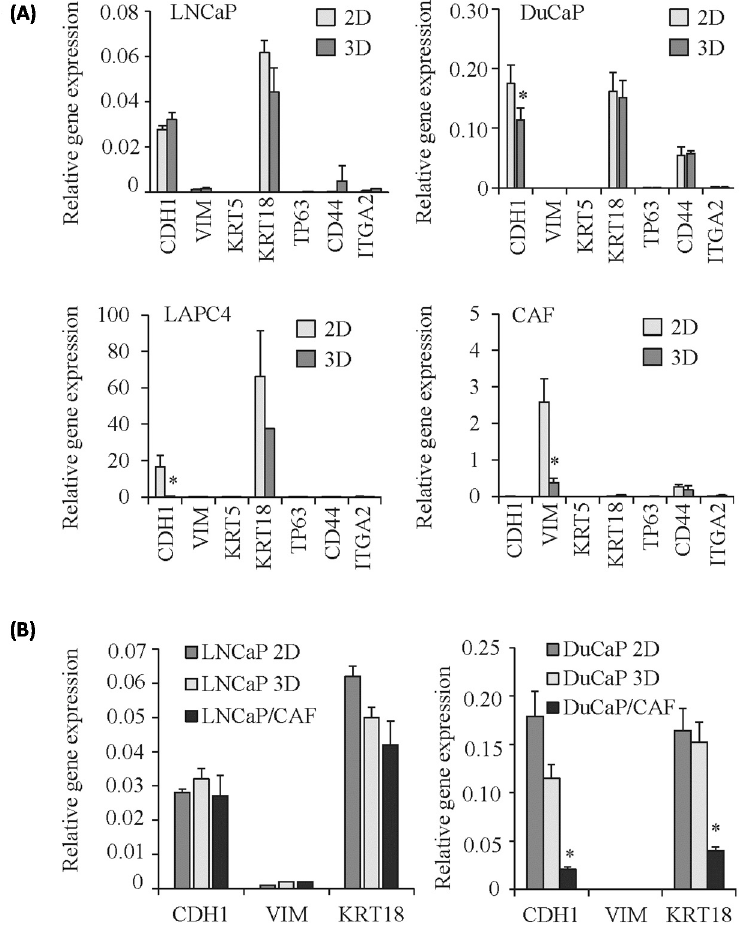
Figure 3. mRNA expression of cell type-specific markers in 3D spheroids compared to 2D monolayers. mRNA expression of the luminal epithelial markers E-cadherin (CDH1) and cytokeratin 18 (KER18), the stromal marker vimentin (VIM), the basal epithelial cell markers keratin 5 (KER5) and TP63, and the two cell surface glycoproteins CD44 and CD49b (ITGA2) in ( A ) 3D monoculture spheroids compared to corresponding 2D monolayer cultures and in ( B ) LNCaP/CAF and DuCaP/CAF co-culture spheroids. Target gene expression was normalized to the housekeeping genes GAPDH and HMBS and values expressed as relative gene expression plus SEM from at least three independent experiments (* different from 2D monolayer, p < 0.05).